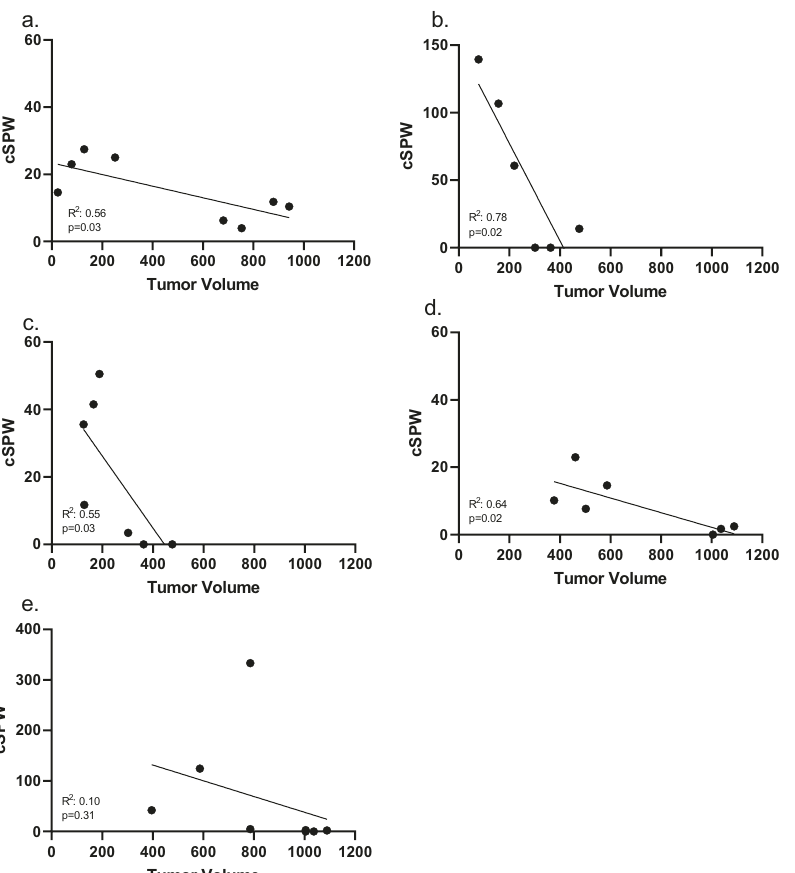
Fig. 4 Vaccination with antigen-speci fi c peptides was immunogenic and IFN-g immune response correlated with smaller tumor volume. Corrected spots per well (CSPW mean peptide wells as compared to no antigen wells using 3.5 × 10 5 cells/well) was correlated by linear regression with tumor volume (mm 3 ) for animals that received vaccination with pooled epitopes to a speci fi c antigens and animals that received PBS controls. IFN-g immune response was evaluated by IFN-g ELISPOT. a VPS35, b ARPC2, c SERBP1, d KRT8, and e PDIA6. R 2 and p value shown in each breast cancer subtypes, and may be good targets for breast cancer vaccines.